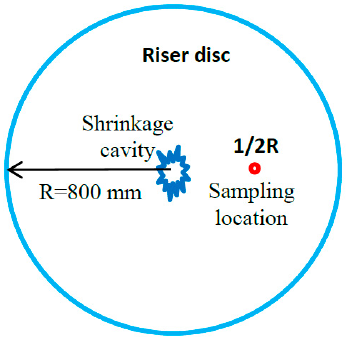
Figure 1. Schematic diagram of sampling location.